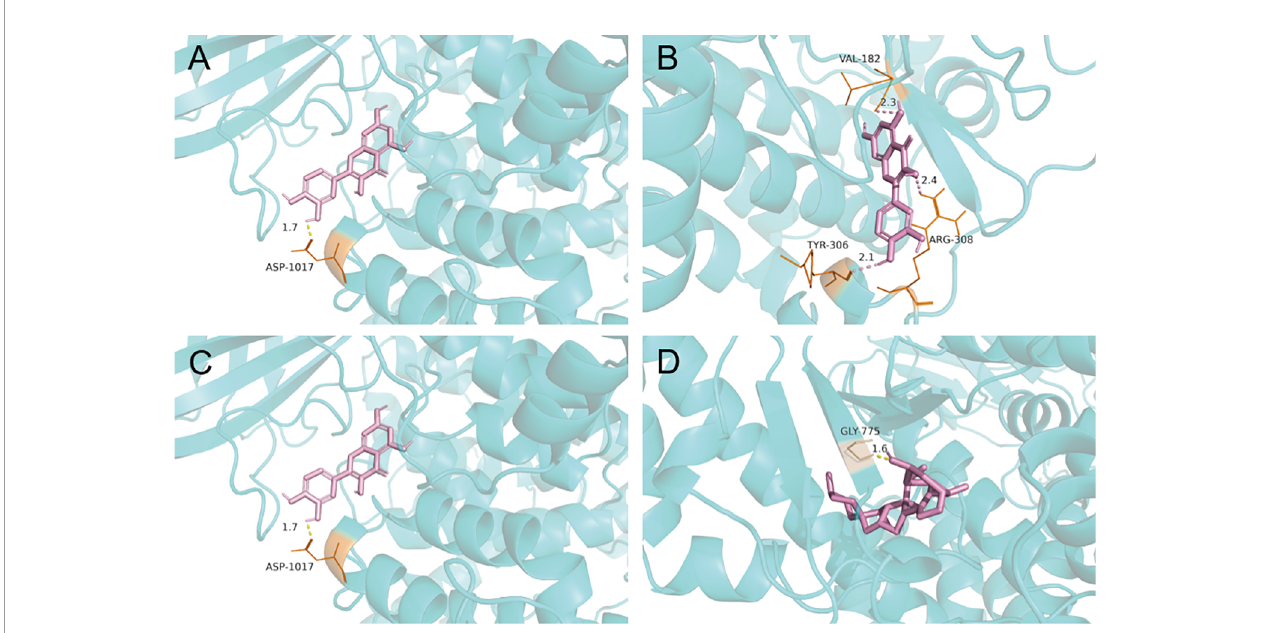
FIGURE 3 | Molecular docking pattern map of quercetin-PI3K (A) ; Molecular docking pattern map of quercetin-AKT (B) ; Molecular docking pattern map of diosgenin-PI3K (C) ; Molecular docking pattern map of diosgenin-AKT (D)